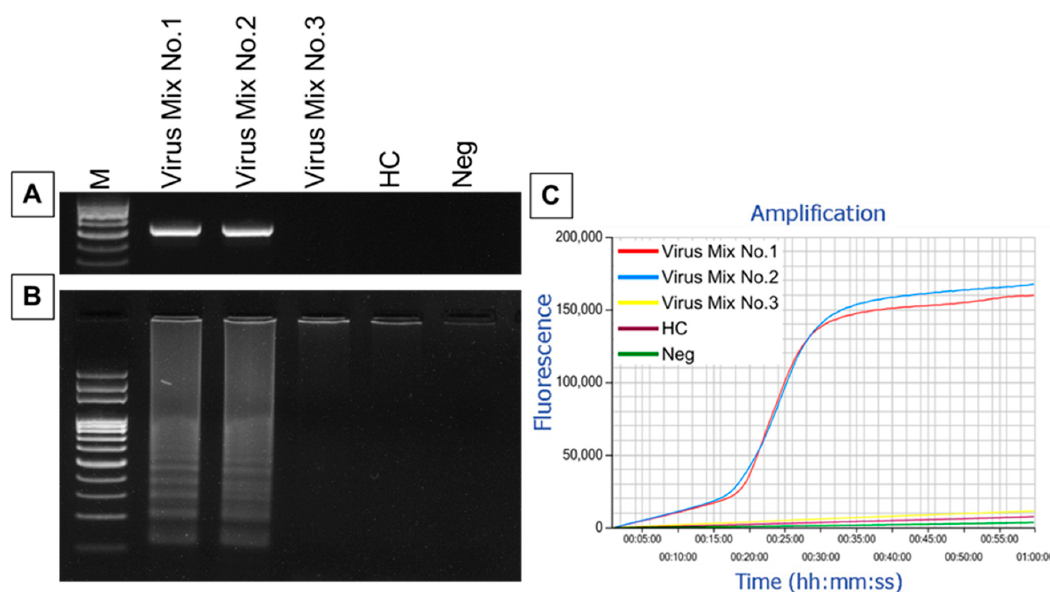
Figure 4. Specificity of the LAMP assay for the detection of CuLCrV in the mix virus assay. CuLCrV was detected from mixed virus DNA with virus-specific primers using PCR ( A ). LAMP